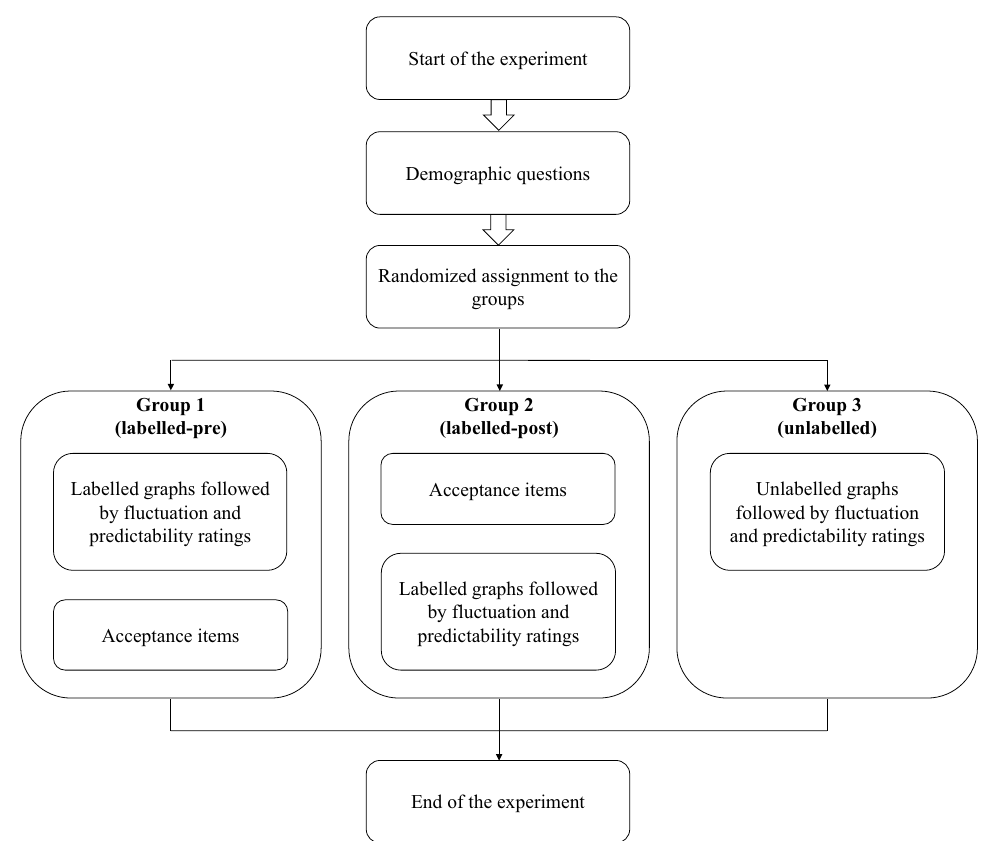
Fig. 2 Design and procedure of the